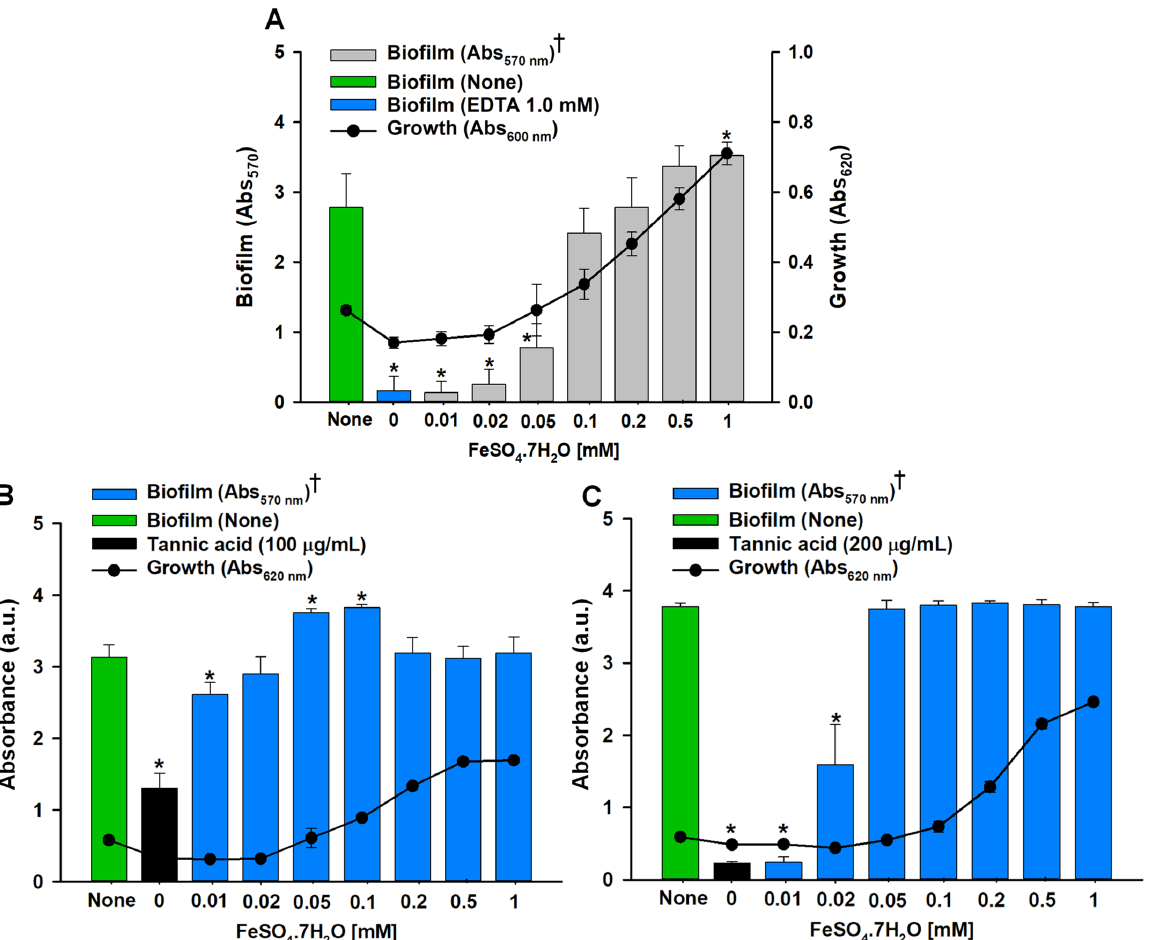
Figure 4. Effect of iron limitation on growth and biofilm formation of A. tumefaciens . Line and scatter plots represent cell growth absorbance at 620 nm and bars show the amount of biofilm produced (570 nm) in 96 ‐ well microtiter plates after 48 h incubation at 30 °C in LB. Effect of increasing concentrations of iron source (Fe 2 SO 4 ∙ 7H 2 O) with constant EDTA (1 mM) (panel ( A )), constant 100 μ g/mL tannic acid (panel ( B )), and 200 μ g/mL tannic acid (panel ( C )). Bar for ‘none’ shows biofilm formation without EDTA or tannic acid or Fe 2 SO 4 ∙ 7H 2 O. Bio fi lm (570 nm) bars marked with ‘†’ show